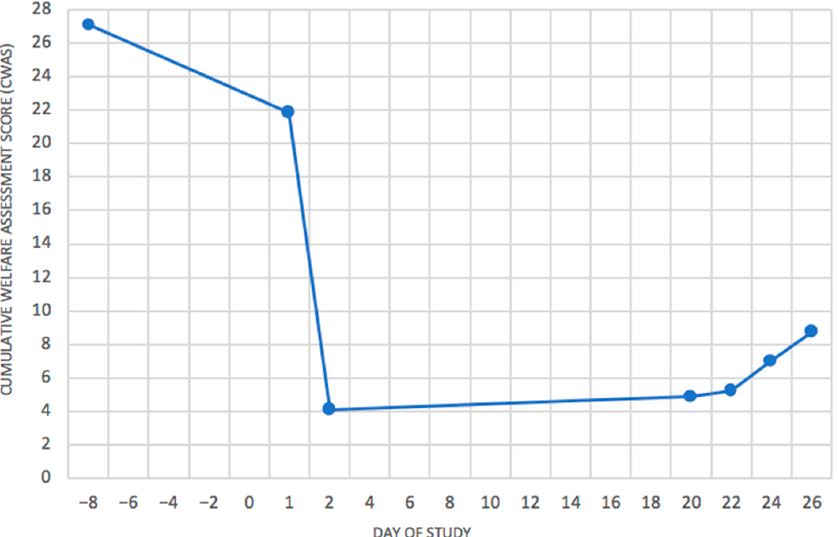
Figure 3. Cumulative welfare Assessment Score (CWAS) Timeline for a vaccinated bovine starting from Day − 8. The cumulative welfare assessment scores are calculated from the area of the animal’s cruciform grids for each event. These are then plotted on the graph to display welfare over the animal’s lifetime. This demonstrates the impact transport (Day − 8) had on welfare, as well as the effect of infection with FMD on Day 22.